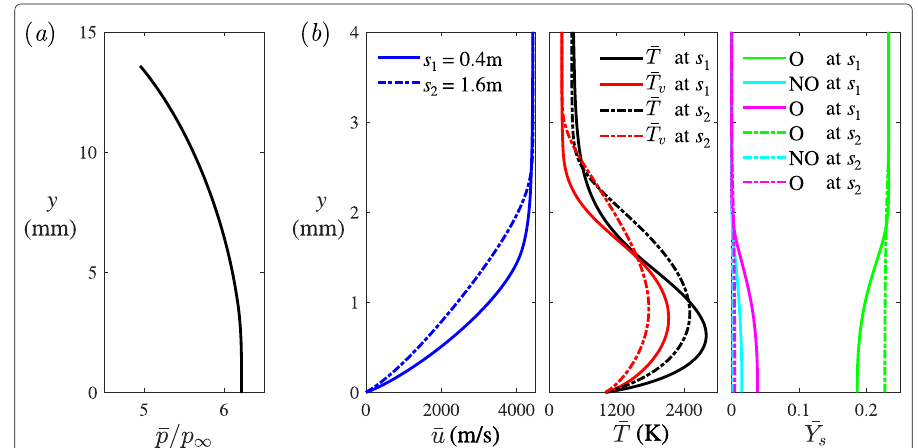
Fig. 2 Laminar boundary-layer profiles of ( a ) the pressure at s = 0.4m , ( b ) the streamwise velocity, temperature and mass fraction at s of 0.4m and 1.6m